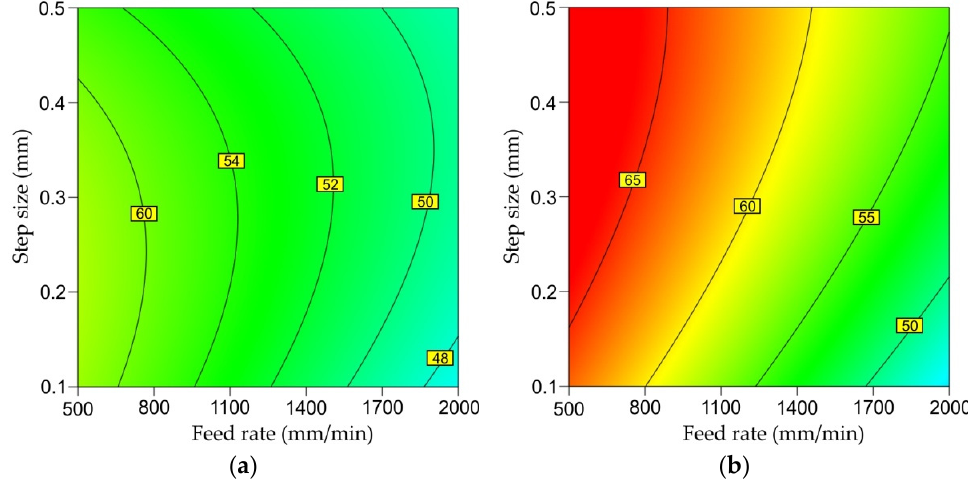
Figure 15. Plots showing the effect of feed rate and step size on maximum formable wall angle α max for ( a ) clockwise and ( b ) anticlockwise direction of tool rotation.